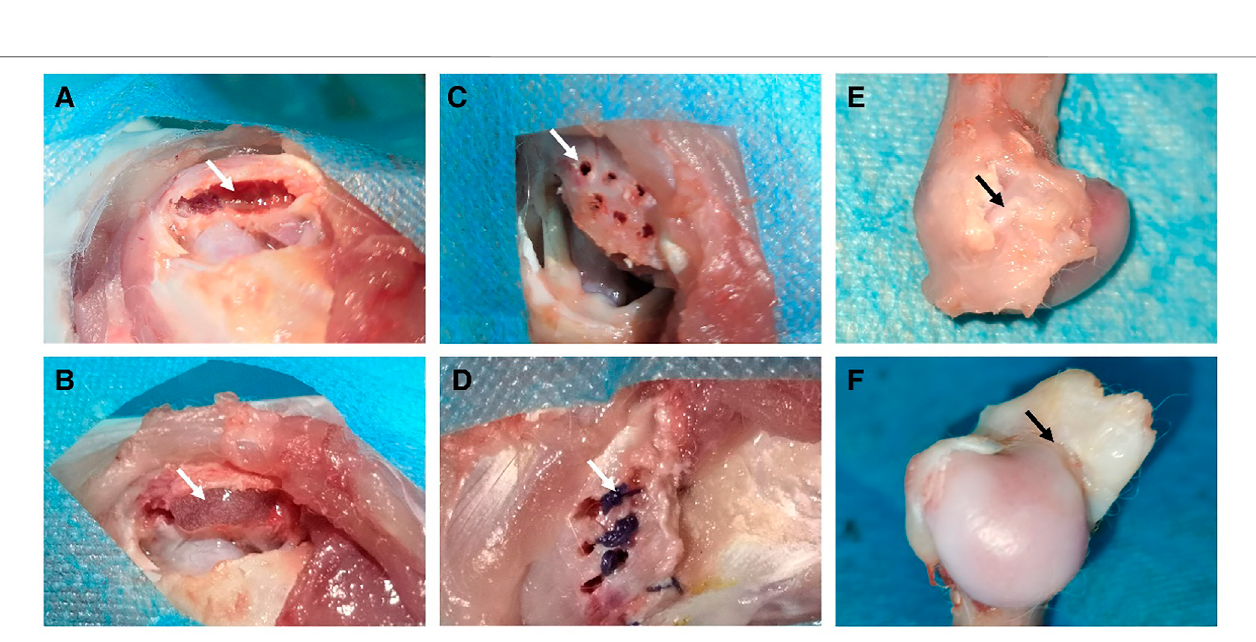
Frontiers in Materials |